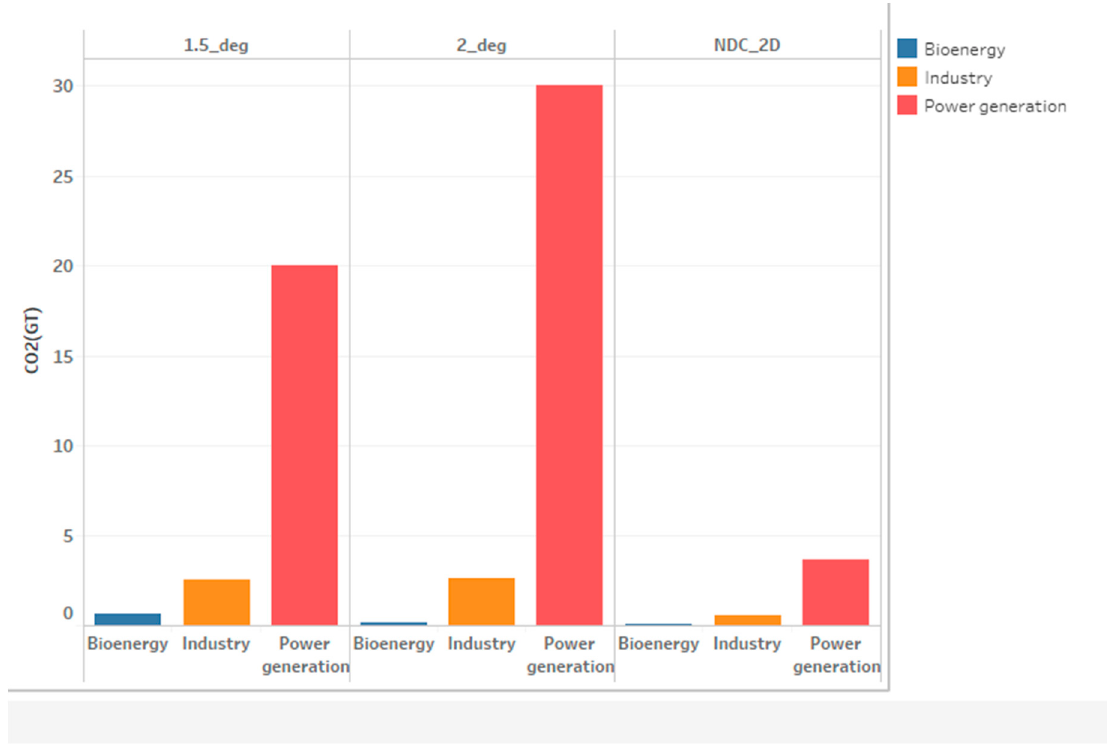
Figure 4. Cumulative Carbon Sequestered by CCS (Gt of CO 2 ).